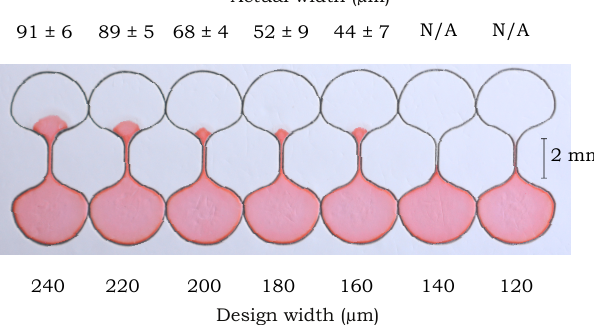
Figure 3. Testing small-scale channels of different width with dye solution to determine the smallest